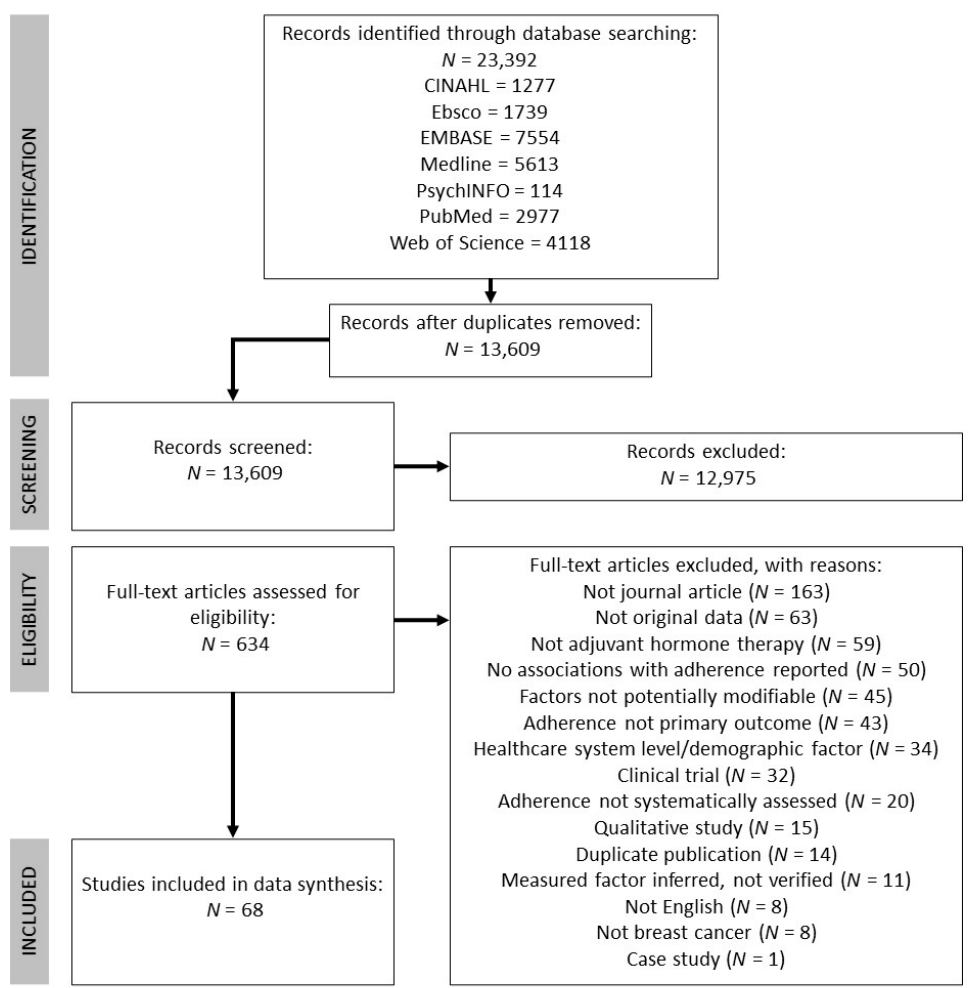
Figure 1. Flow chart detailing record identification, screening, and inclusion, adapted from PRISMA guidelines [19].